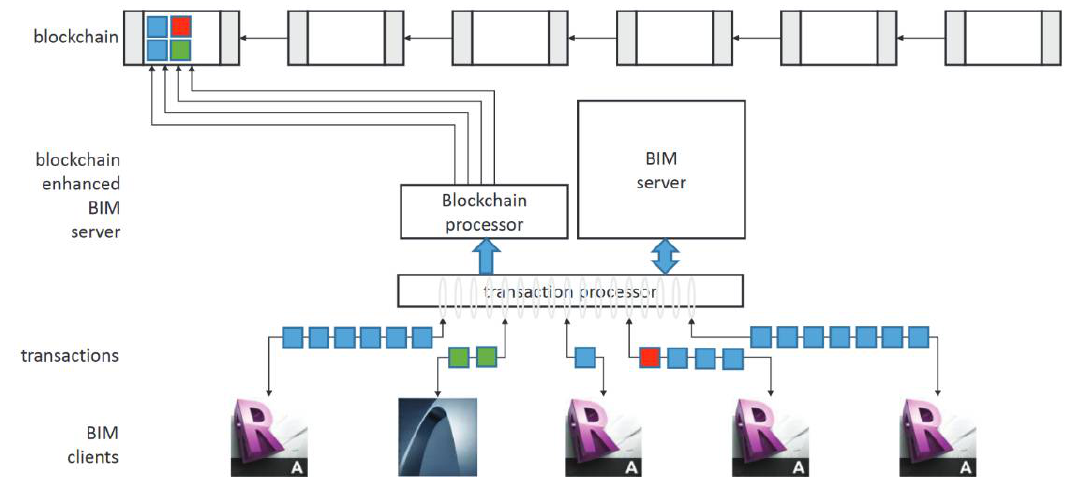
Figure 10. Taxonomy of blockchain management. Reprinted/Adapted with permission from Reference [71]. Copyright 2017 Copyright Elsevier Ltd.